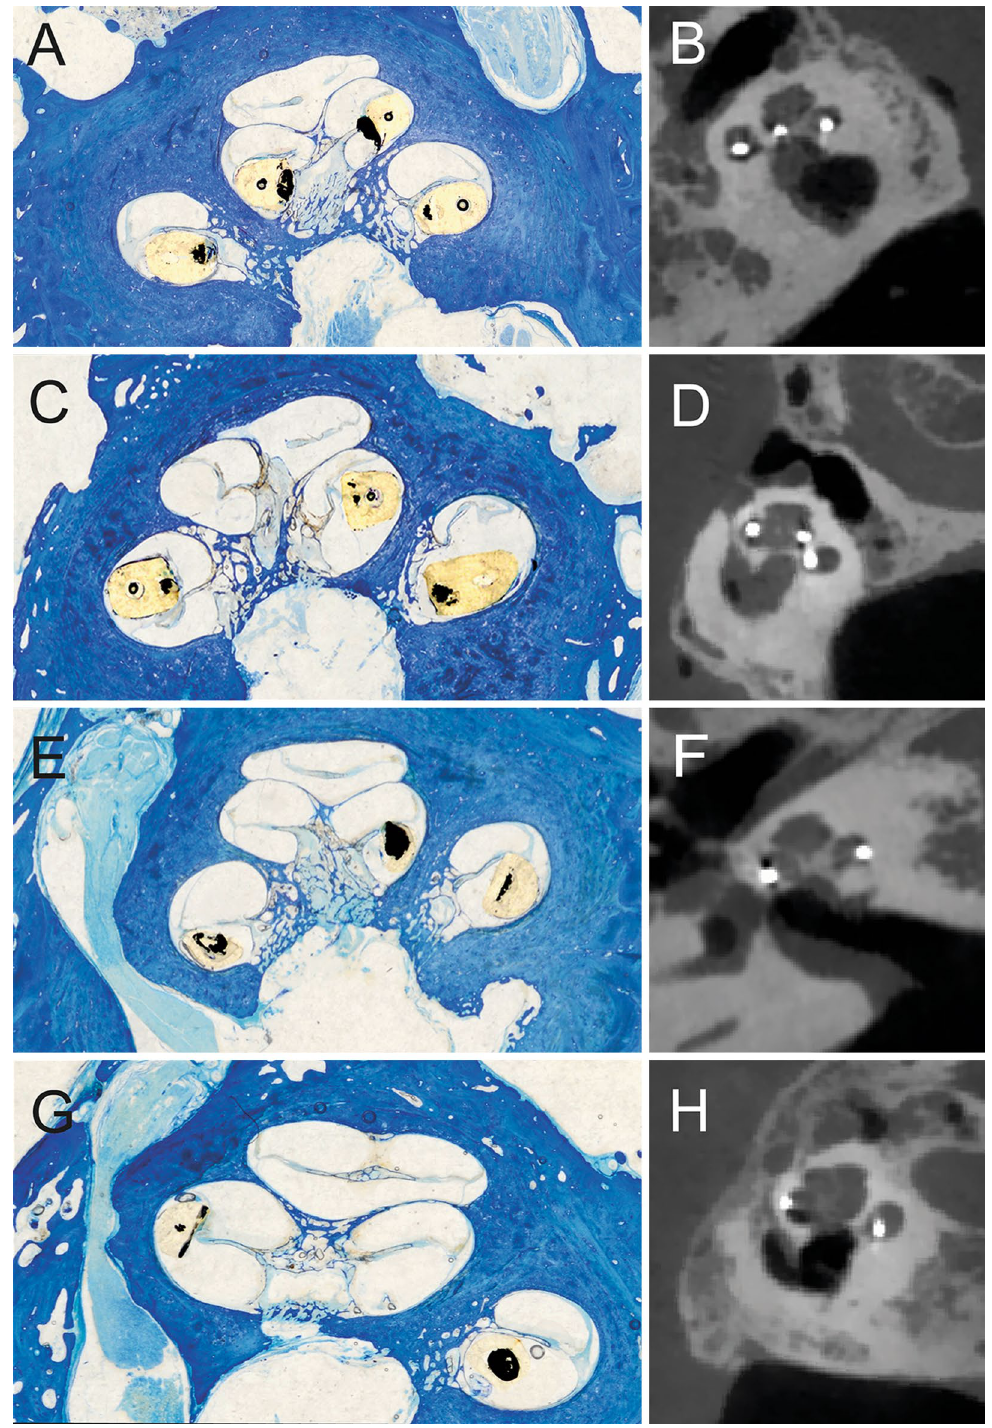
Figure 2. Histological modiolar plane sections and corresponding CT images were compared. Similar array positions were observed between histology and radiology. In ( A,B ) non-STL PM array. In ( C,D ) non-STL LW array. In ( E,F ) STL PM array. In ( G,H) STL LW array. Note: the diameter of the array was increased 30–40% due to swelling of the silicon layer after processing with butyl methacrylate. Contrast of array was increased for visibility